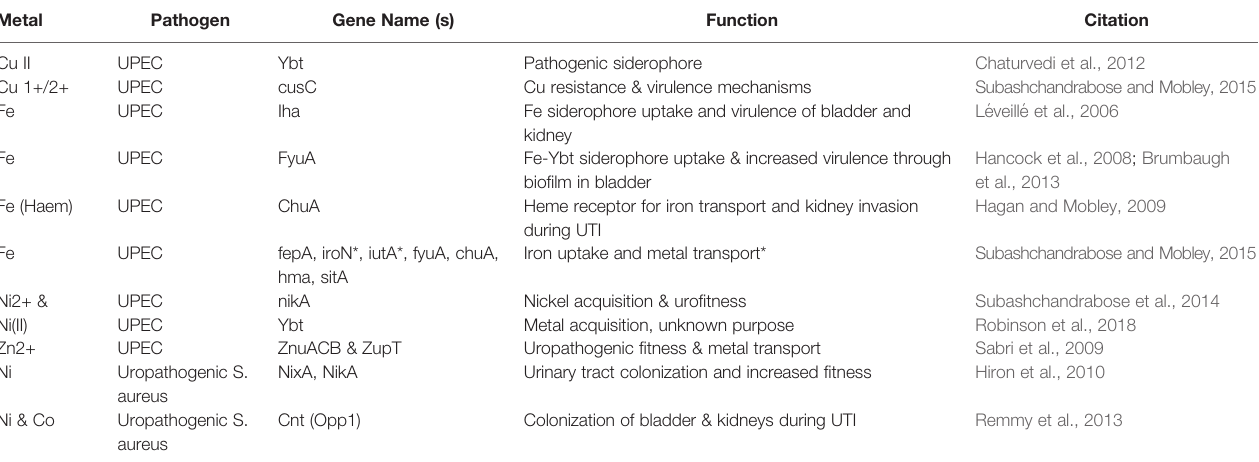
TABLE 3 | Uropathogenic uptake of various metals to incite virulence in host